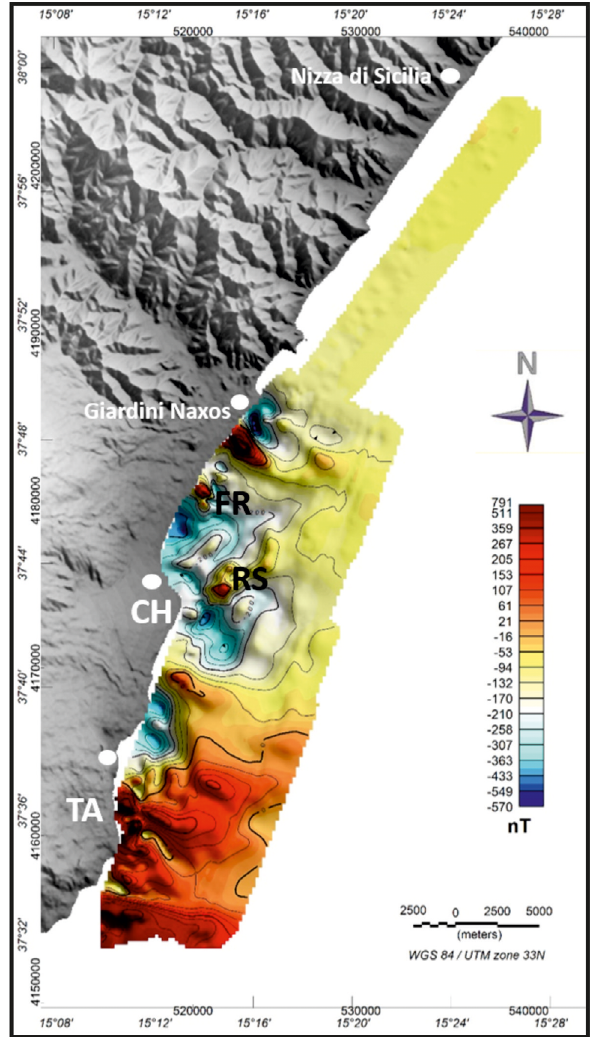
Figure 9. Total intensity magnetic anomaly field offshore Mt. Etna. Grid cell size is 200 m; contours intervals are every 50 nT. CH (Chiancone volcanoclastic deposit), TA (Timpa area), TSC (Timpa sea-cliff), RS (Riposto Shoal), FR (Fondachello Ridge).